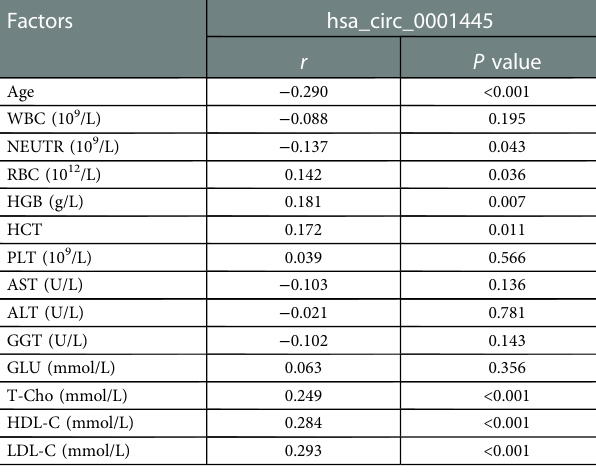
TABLE 2 Correlations between hsa_circ_0001445 expression level and clinical parameters of CHD patients. Factors